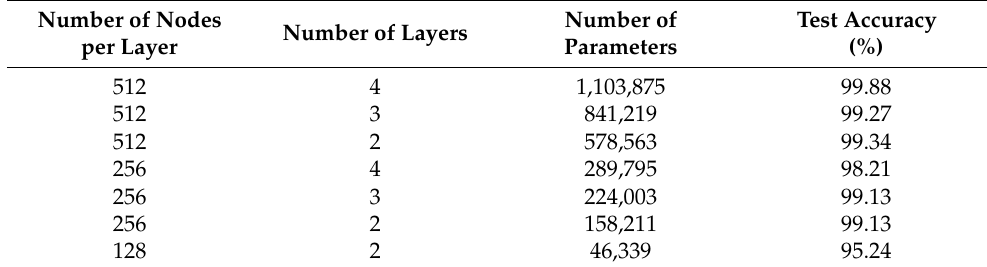
Table 3. Fault detection accuracy according to network size for